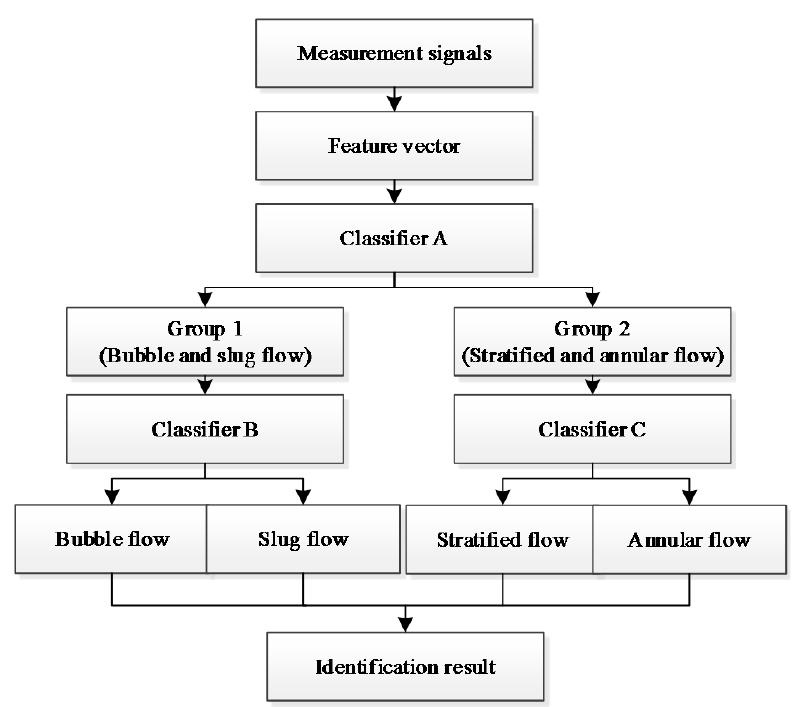
Figure 4. The flowchart of the flow pattern identification.